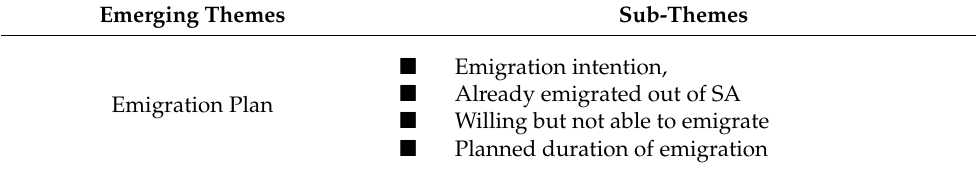
Table 2. Emerging themes and